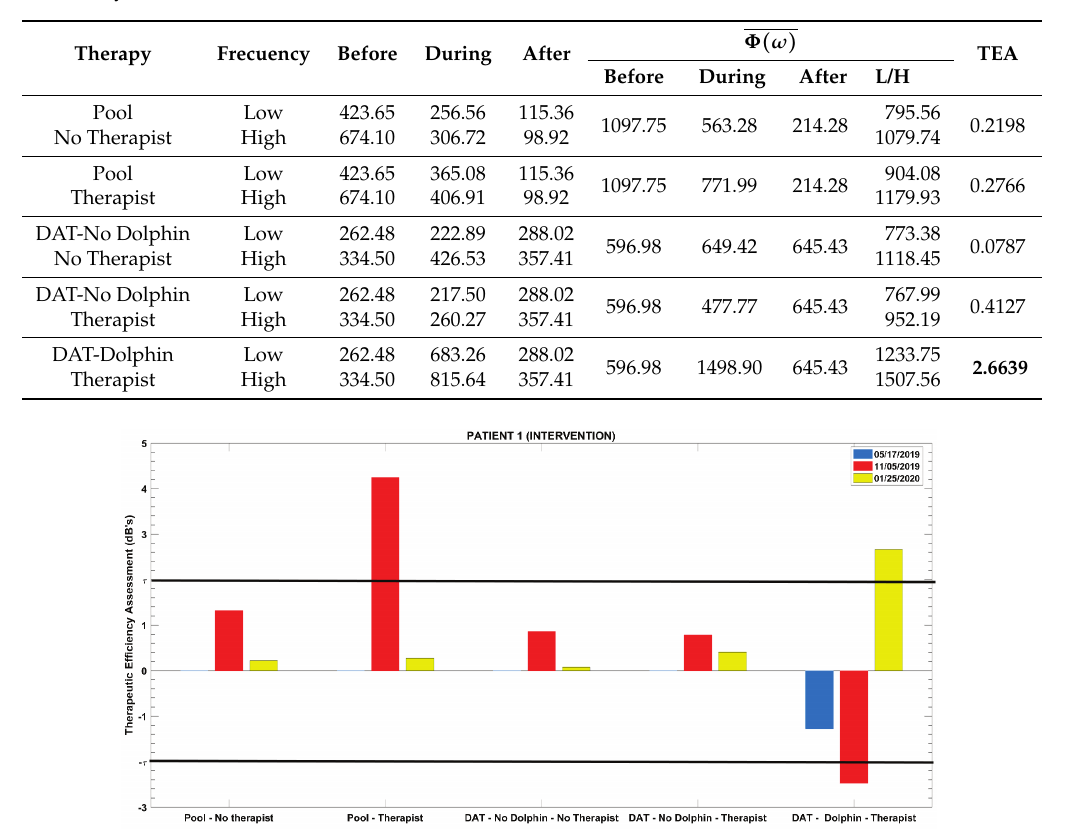
Figure 19. Results of the Patient 1 (Intervention), On 05/17/2019, 11/05/2019 and 01/25/2020. Continuous line indicates an efficiency threshold of ± 2 dB of TEA.